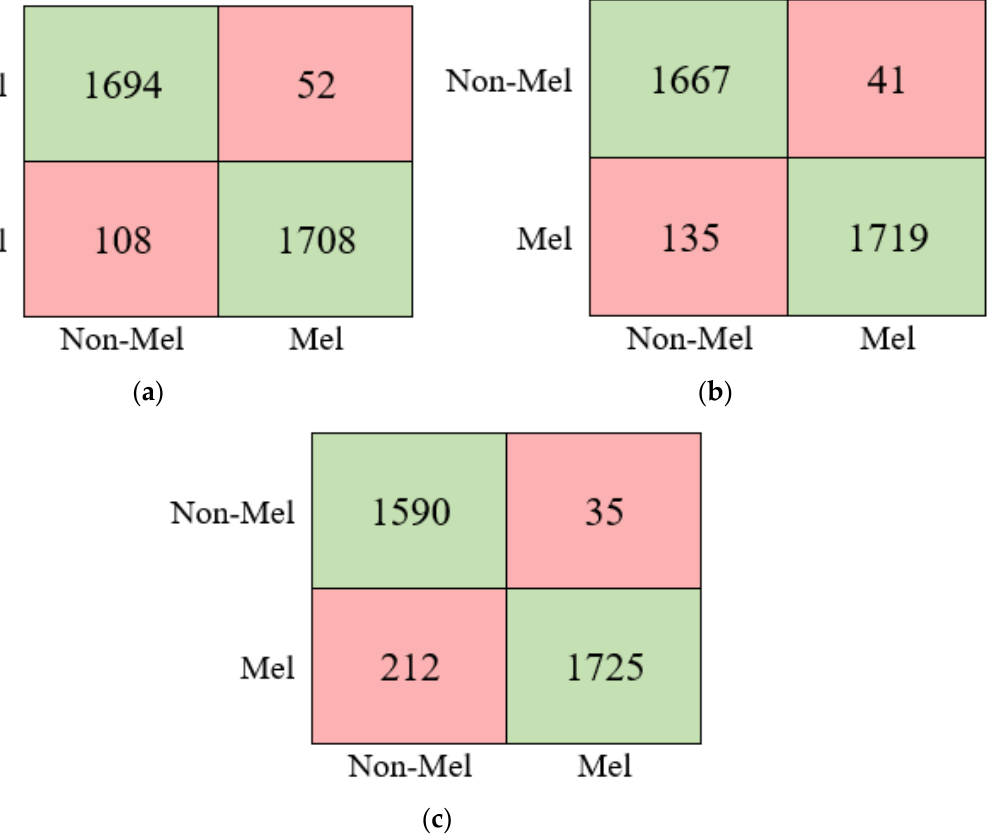
Figure 8. The confusion matrices of pre-trained deep models, ( a ) DenseNet, ( b ) MobileNet, ( c ) GoogleNet.